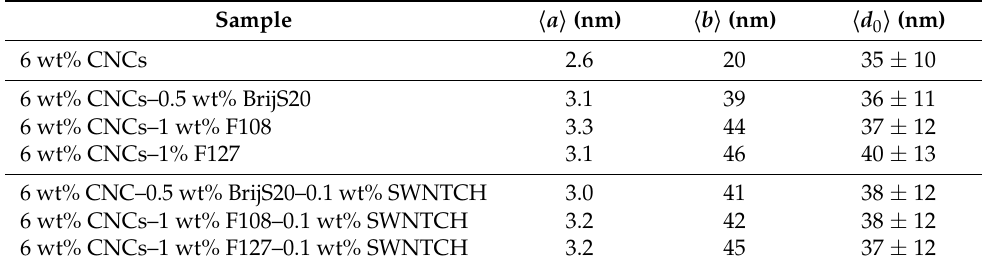
Table 3. The typical thickness (cid:104) a (cid:105) , width (cid:104) b (cid:105) , and the inter-plate distance (cid:104) d 0 (cid:105) as determined from the parallelepiped stacking